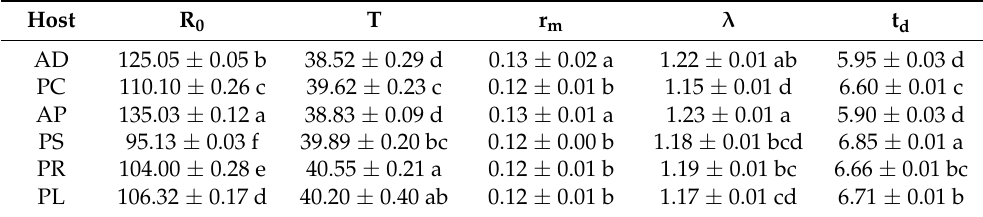
Table 3. Life table parameters of G. molesta fed on different hosts.